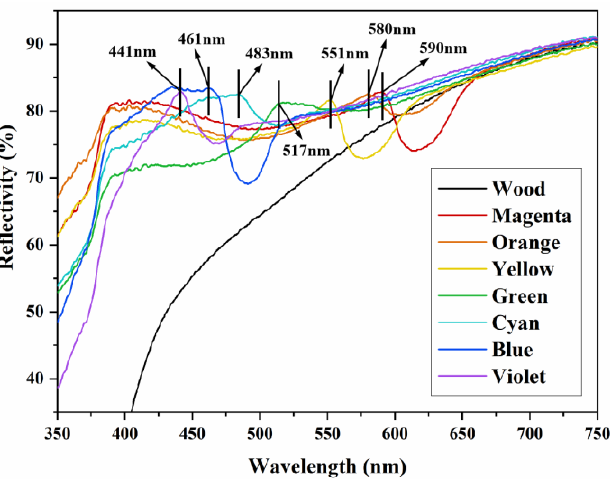
Figure 15. Reflection spectra of PSt microspheres self-assembled into coatings with different struc- tural colors.